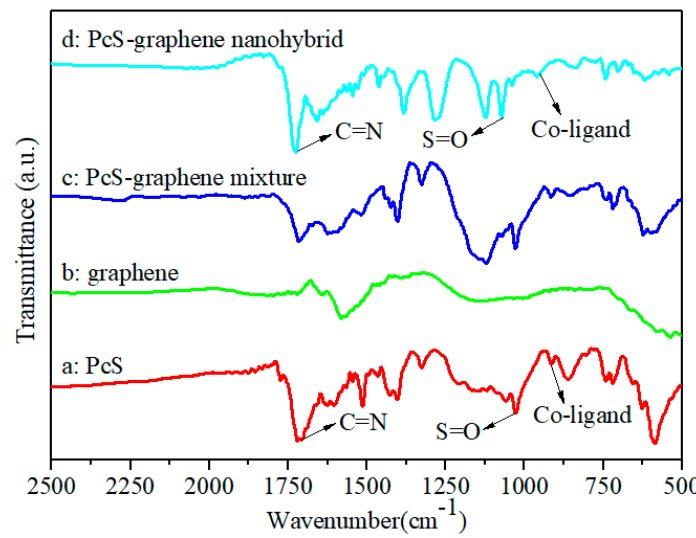
Figure 4. Fourier transform infrared spectroscopy (FT-IR) spectra of ( a ): PcS, ( b ): graphene, ( c ): PcS–graphene mixture, and ( d ): PcS–graphene nanohybrid.